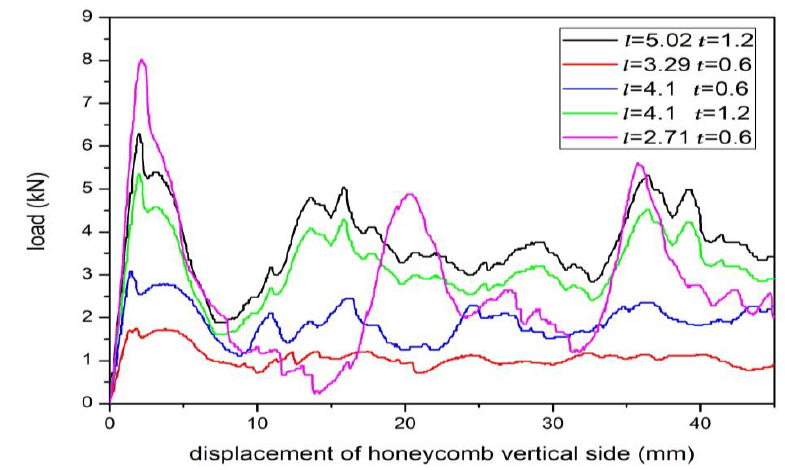
Figure 3. Load displacement curves for various honeycomb cell wall length ( l ) and thickness ( t ).